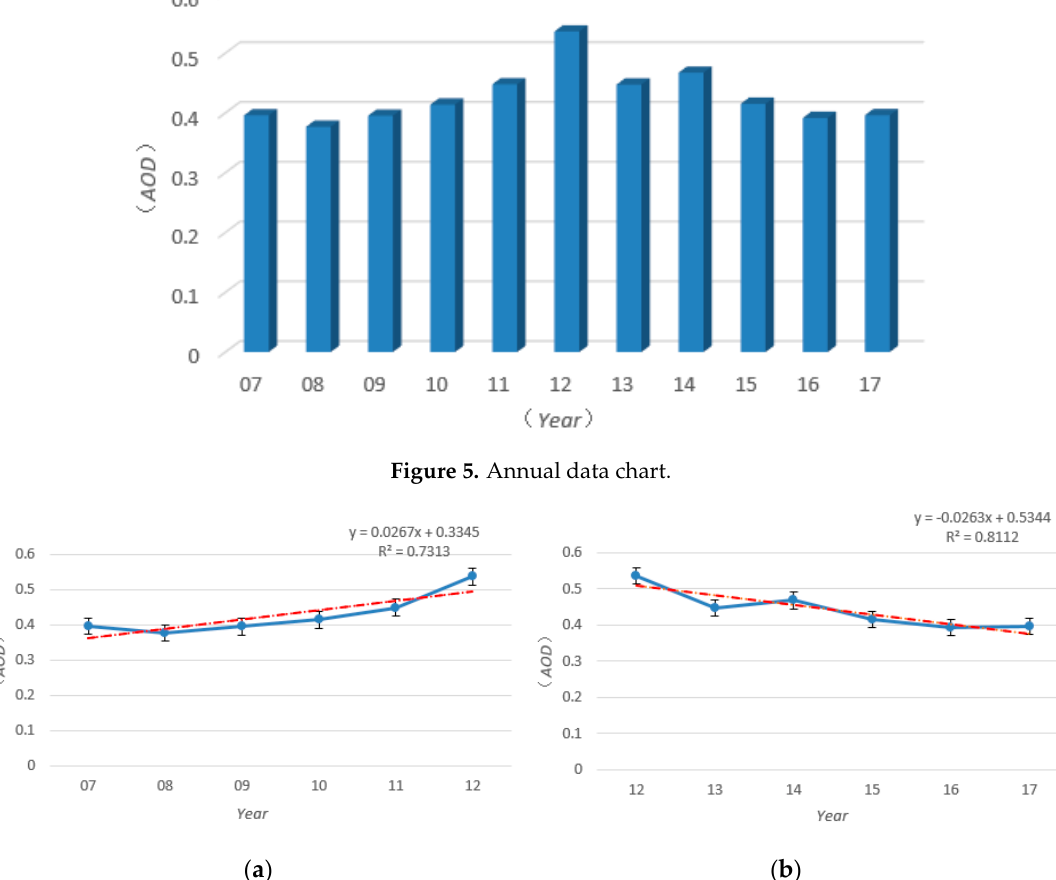
Figure 6. Linear trend chart. ( a ) Trends from 2007 to 2012, ( b ) Trends from 2012 to 2017.